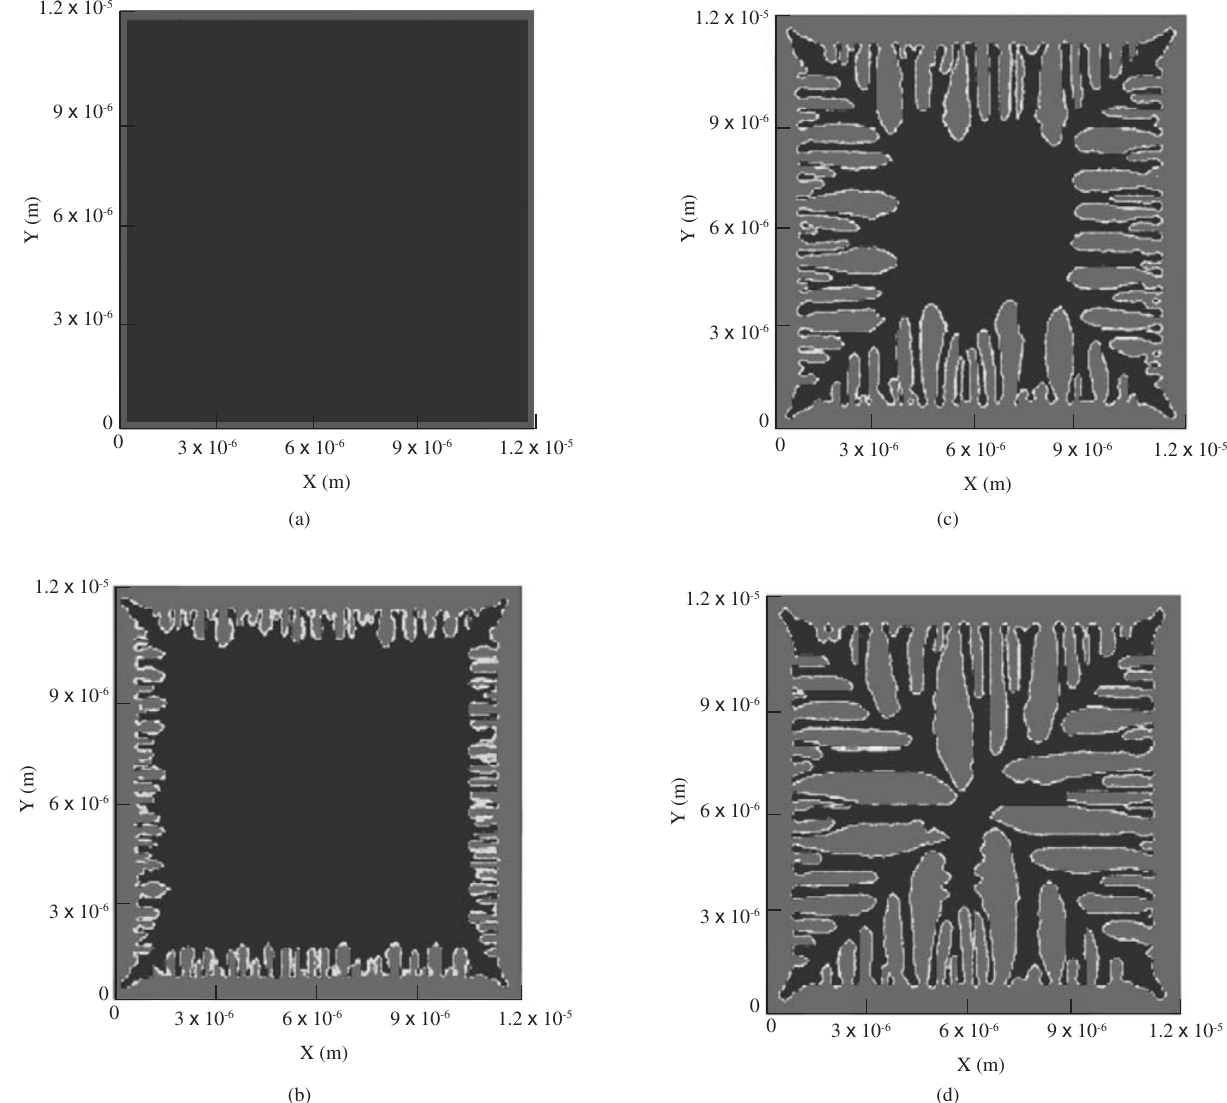
Figure 4. Evolution of an unstable interface into a supercooled melt. Solidification time is a) t = 0; b) 2.6 x 10 -8 s; c) t = 7.5 x 10 -8 s; and d) t = 4.6 x 10 -7